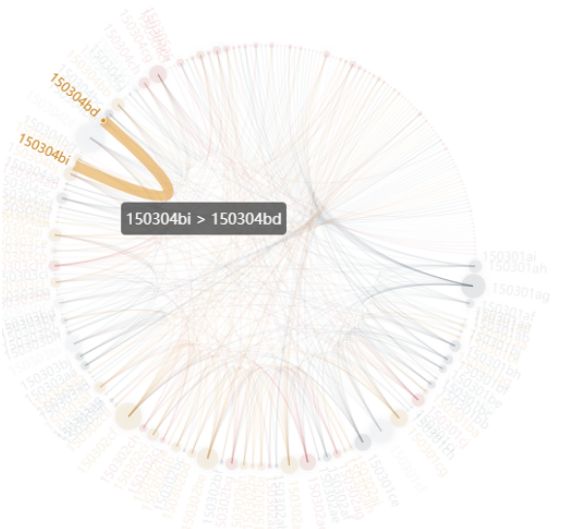
Figure 5. Chord diagram representing social relationship of student 150304bi.